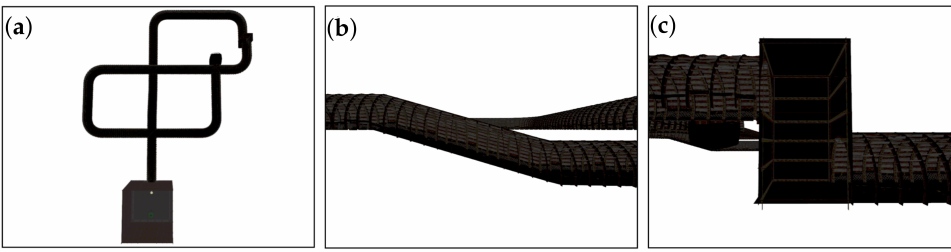
Figure 13. DARPA SubT simulation world: Simple Tunnel 03, 120 m × 100 m × 10 m. ( a ) Top-down view of tunnel environment showing banked turns. ( b ) Side-view of a ramp section where a descent of approximately 7 m occurs over 20 m of forward motion. ( c ) Side-view of vertical shaft section, which spans about 10 m